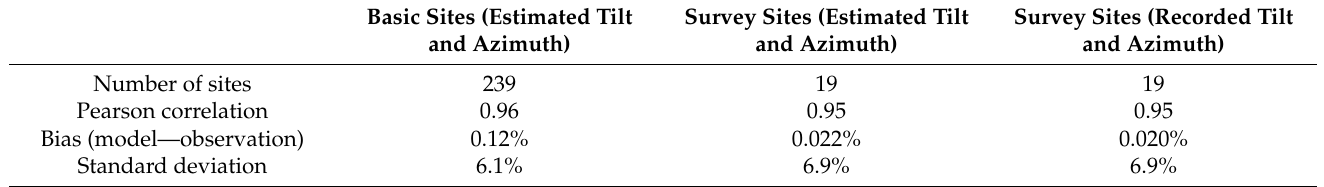
Table 3. Mean hourly error statistics for the snow-free models normalized with installed effect.